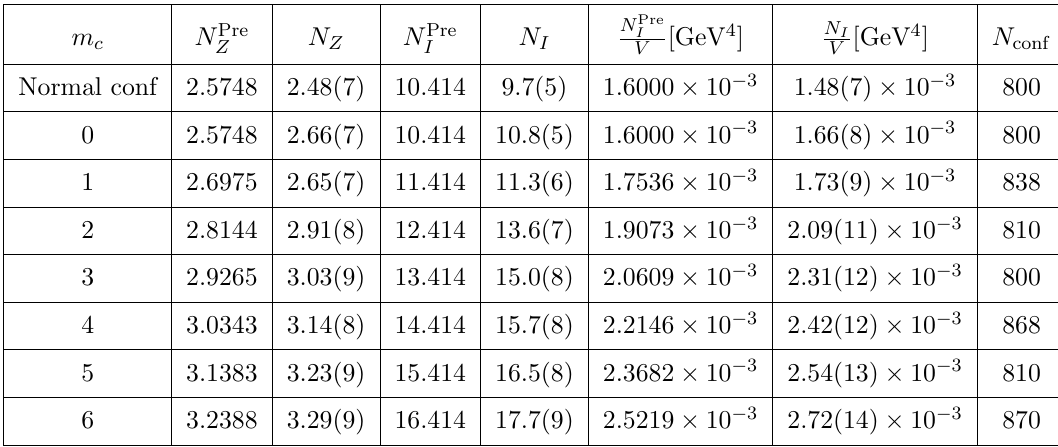
Table 4 . The results of the number of zero modes N Z , the total number of instantons and anti- instantons N I , and the instanton density N I . The superscript Pre indicates the predicted values. V